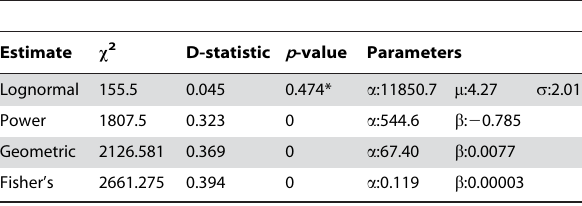
Table 2. Evaluation of the fit of different distributions to GC- TRFLP data from the soil